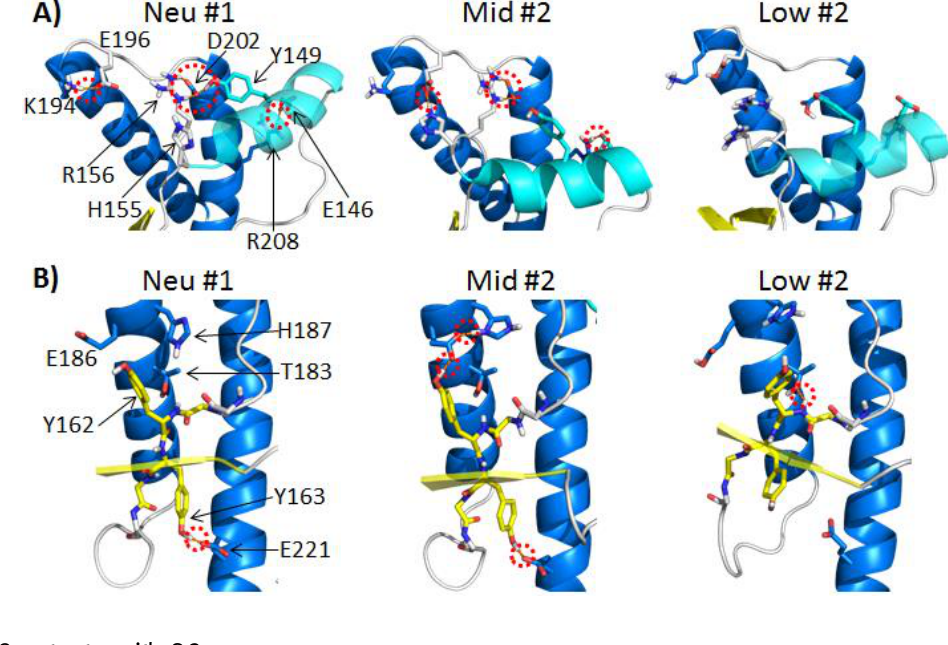
Figure 4. Changes in polar contacts at different pH. Structures from neutral pH Simulation 1, mid-pH Simulation 2 and low pH Simulation 2 at 30 ns are shown in (A) and (B). Red dotted circles indicate polar contacts. Relevant polar residues are shown as sticks. (A) Relevant polar contacts around HA, where HA is colored in cyan. (B) Relevant polar contacts around S2, where the backbone of S2 is shown as sticks with carbon atoms colored in